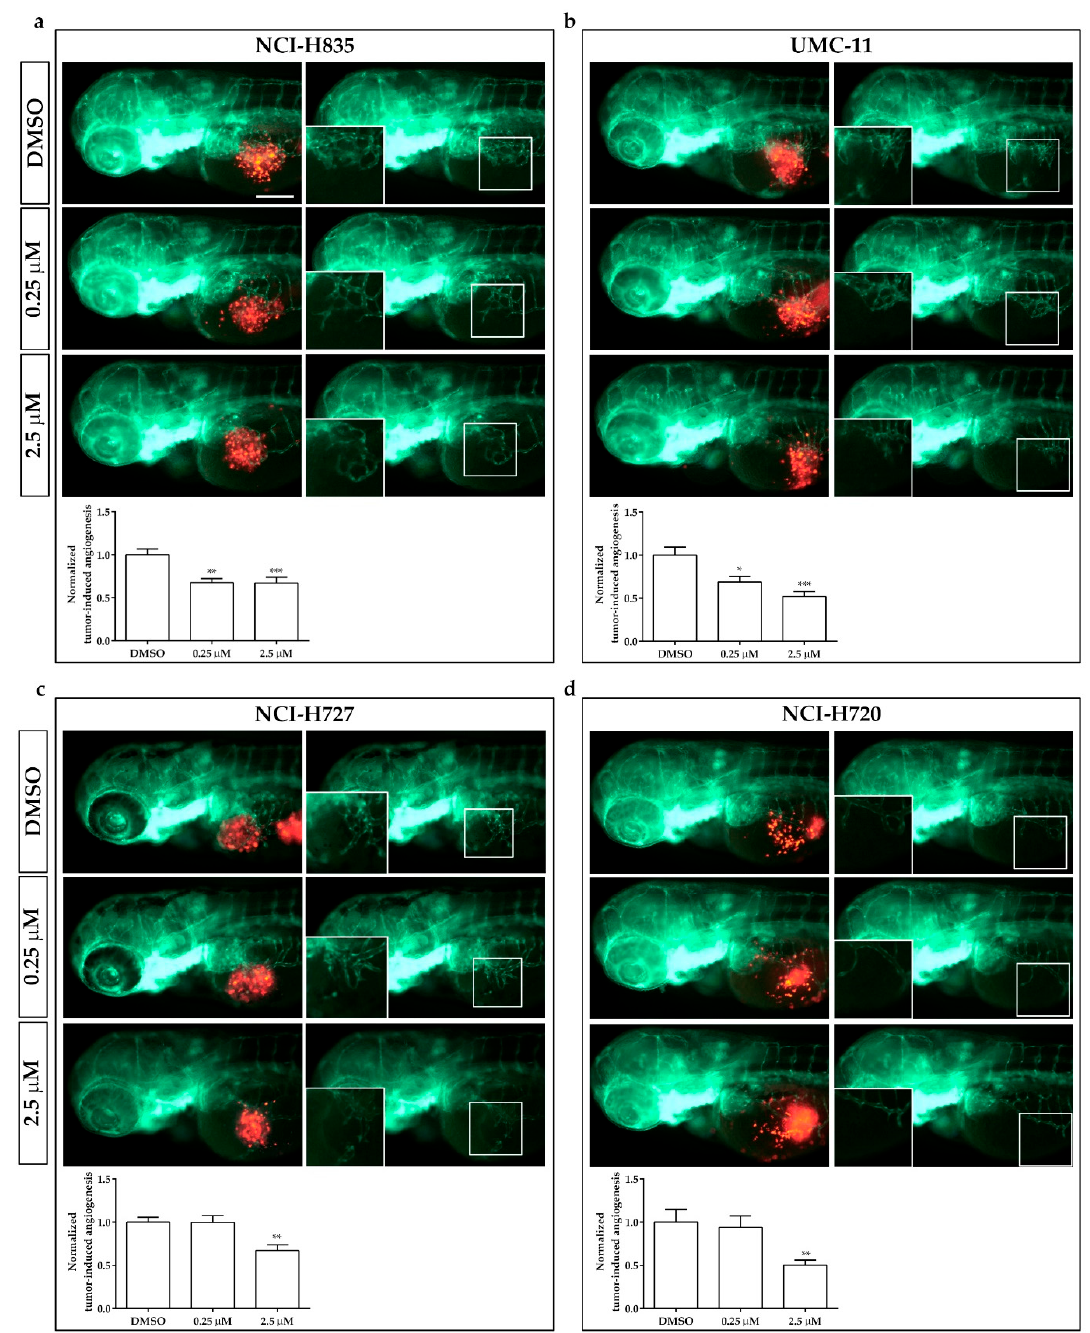
Figure 6. Effects of sulfatinib on tumor-induced angiogenesis in zebrafish embryos implanted with lung carcinoid cells. Representative epifluorescence images of Tg(fli1a:EGFP) y1 zebrafish embryos at 24 hpi, implanted with NCI-H835 ( a ), UMC-11 ( b ), NCI-H727 ( c ), and NCI-H720 ( d ) cells and treated with DMSO (vehicle control) and sulfatinib (0.25 and 2.5 µM). The red channel, corresponding to lung carcinoid cells, was omitted in the second column of each panel to highlight the tumor-induced microvascular network. Digital magnifications of the graft regions are shown in white boxes. At the bottom of each panel, the graph showed the quantification of tumor-induced angiogenesis in embryos implanted with lung carcinoid cells after 24 h of treatment with DMSO and sulfatinib (0.25 and 2.5 µ M). Control (DMSO) values have been set to 1.0. Graphed values represent the mean ± S.E.M. * p < 0.05 vs. DMSO; ** p < 0.01 vs. DMSO; *** p < 0.001 vs. DMSO. Embryos are shown anterior to the left. Scale bar: 100 µ